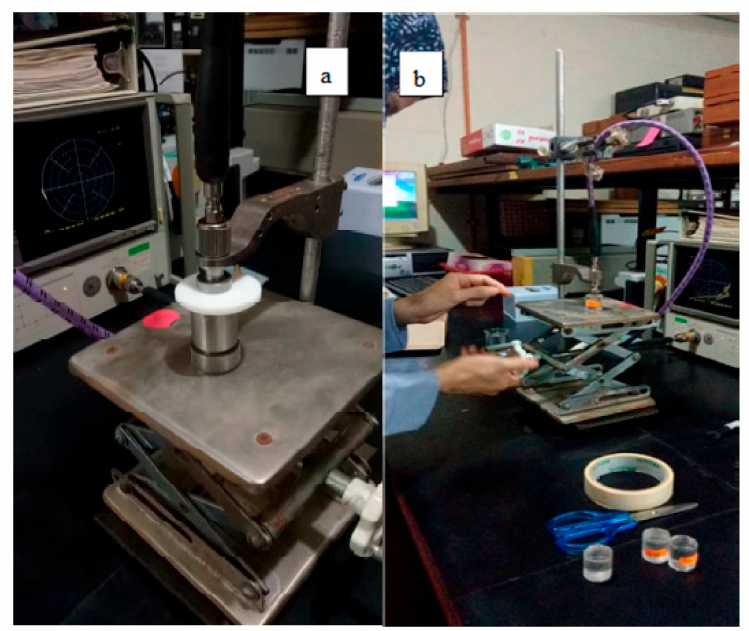
Figure 5. ( a ) Calibration standard of the probe is set by using a standard sample. ( b )